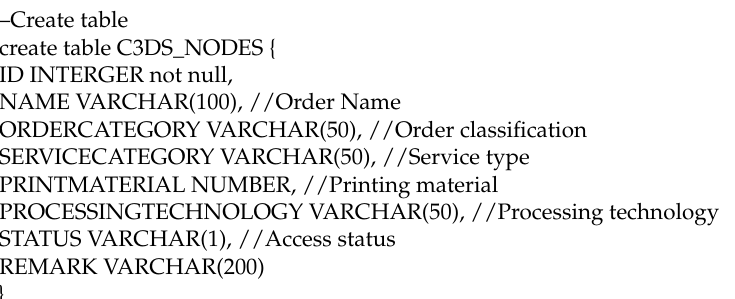
Table 2. Basic information table of service node.